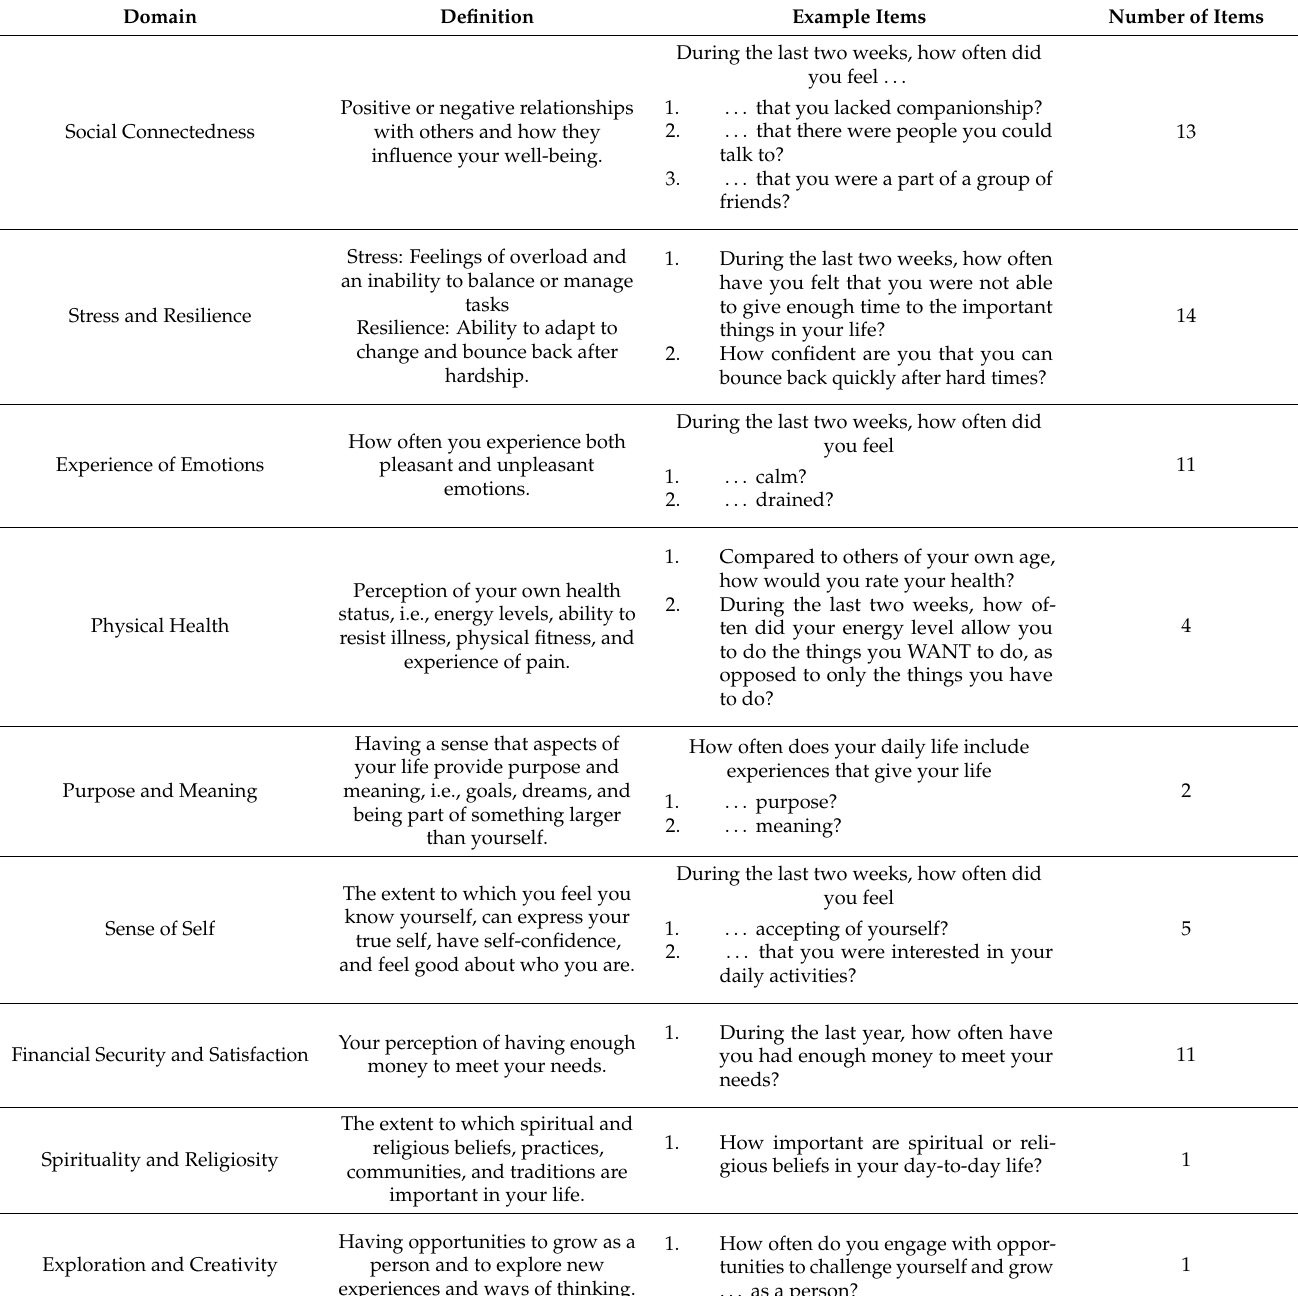
Table 1. Stanford WELL for Life: Constituent Domains of